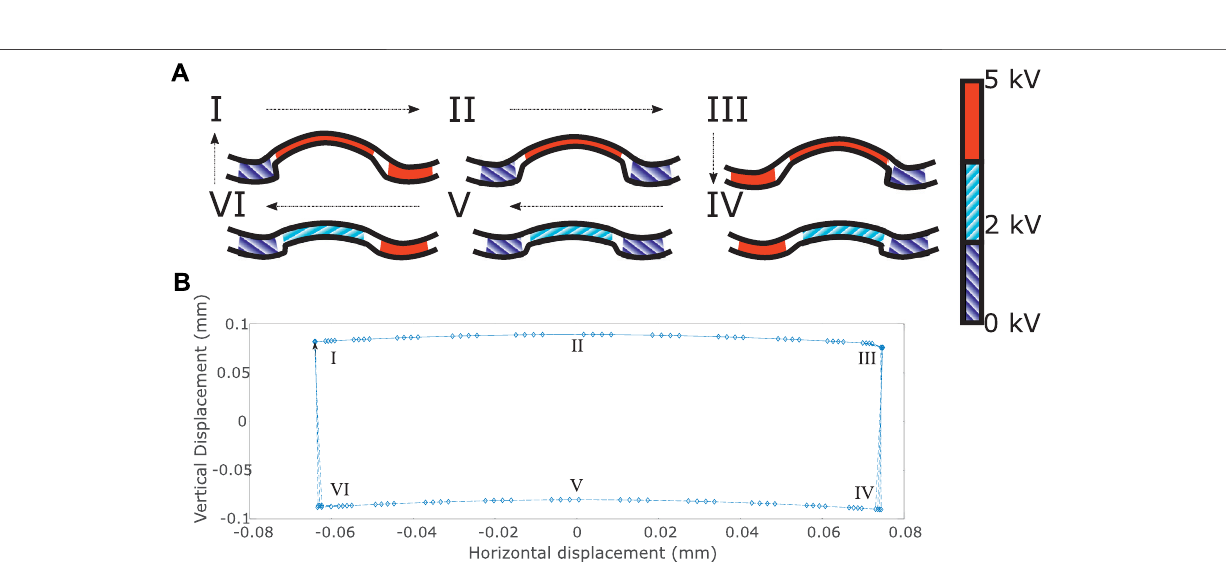
Frontiers in Robotics and AI |